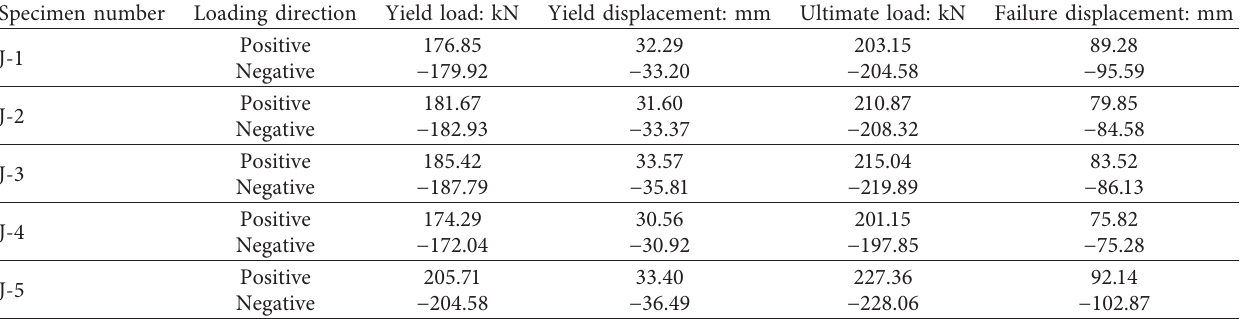
Table 5: Feature points of test results.